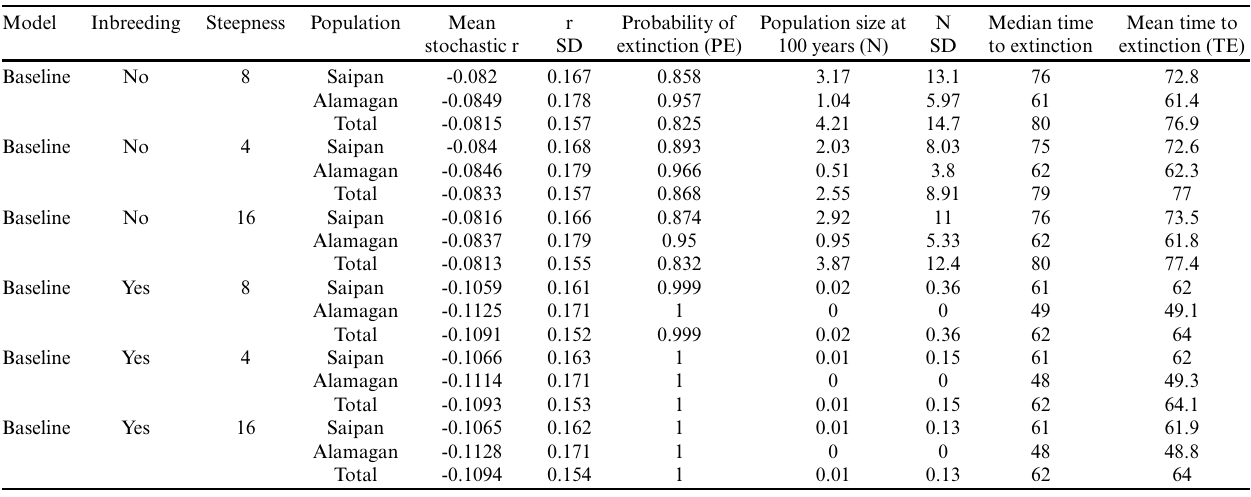
Table 1 . Nightingale Reed-warbler ( Acrocephalus hiwae ) candidate baseline model results. Note that because of the length of time since population estimation (~10 years), the times we report here reflect predicted time to extinction since population estimation, rather than from the present.